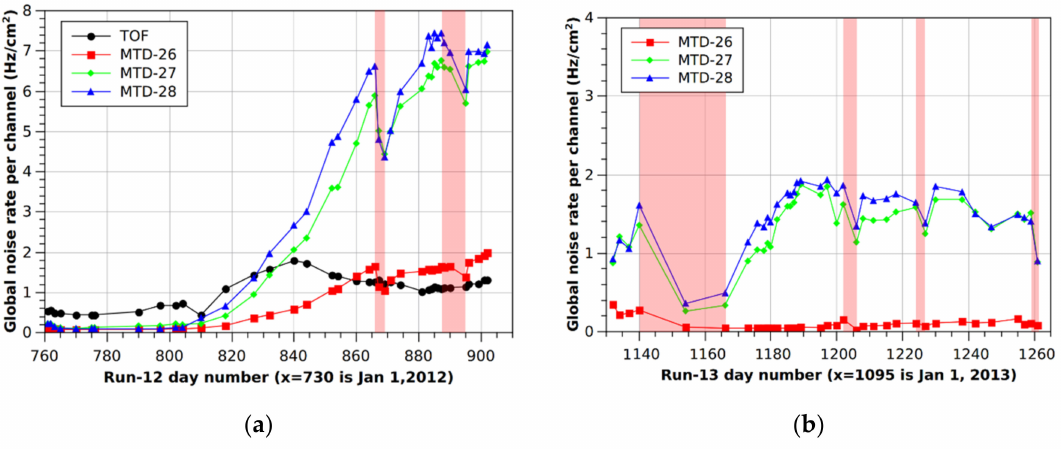
Figure 2. ( a ) The noise of MTD and TOF counters. Red shades mark the response operated with the beam off on that day; ( b ) The noise of MTD counters after blocking the extra gas volume. Figures are reproduced from